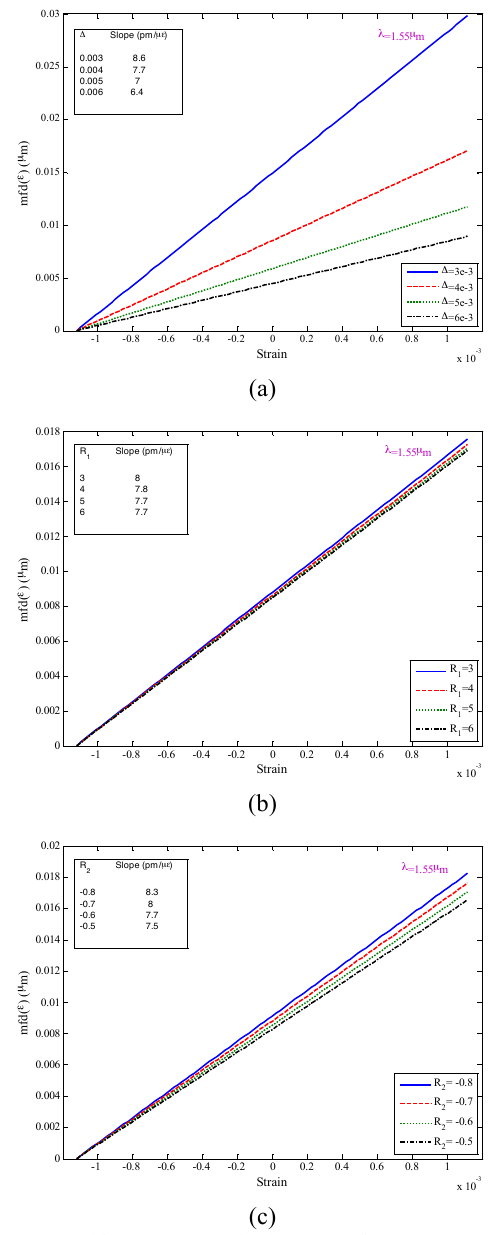
Figure 5: mfd ( µ m ) vs. strain for (a) Δ (b) R